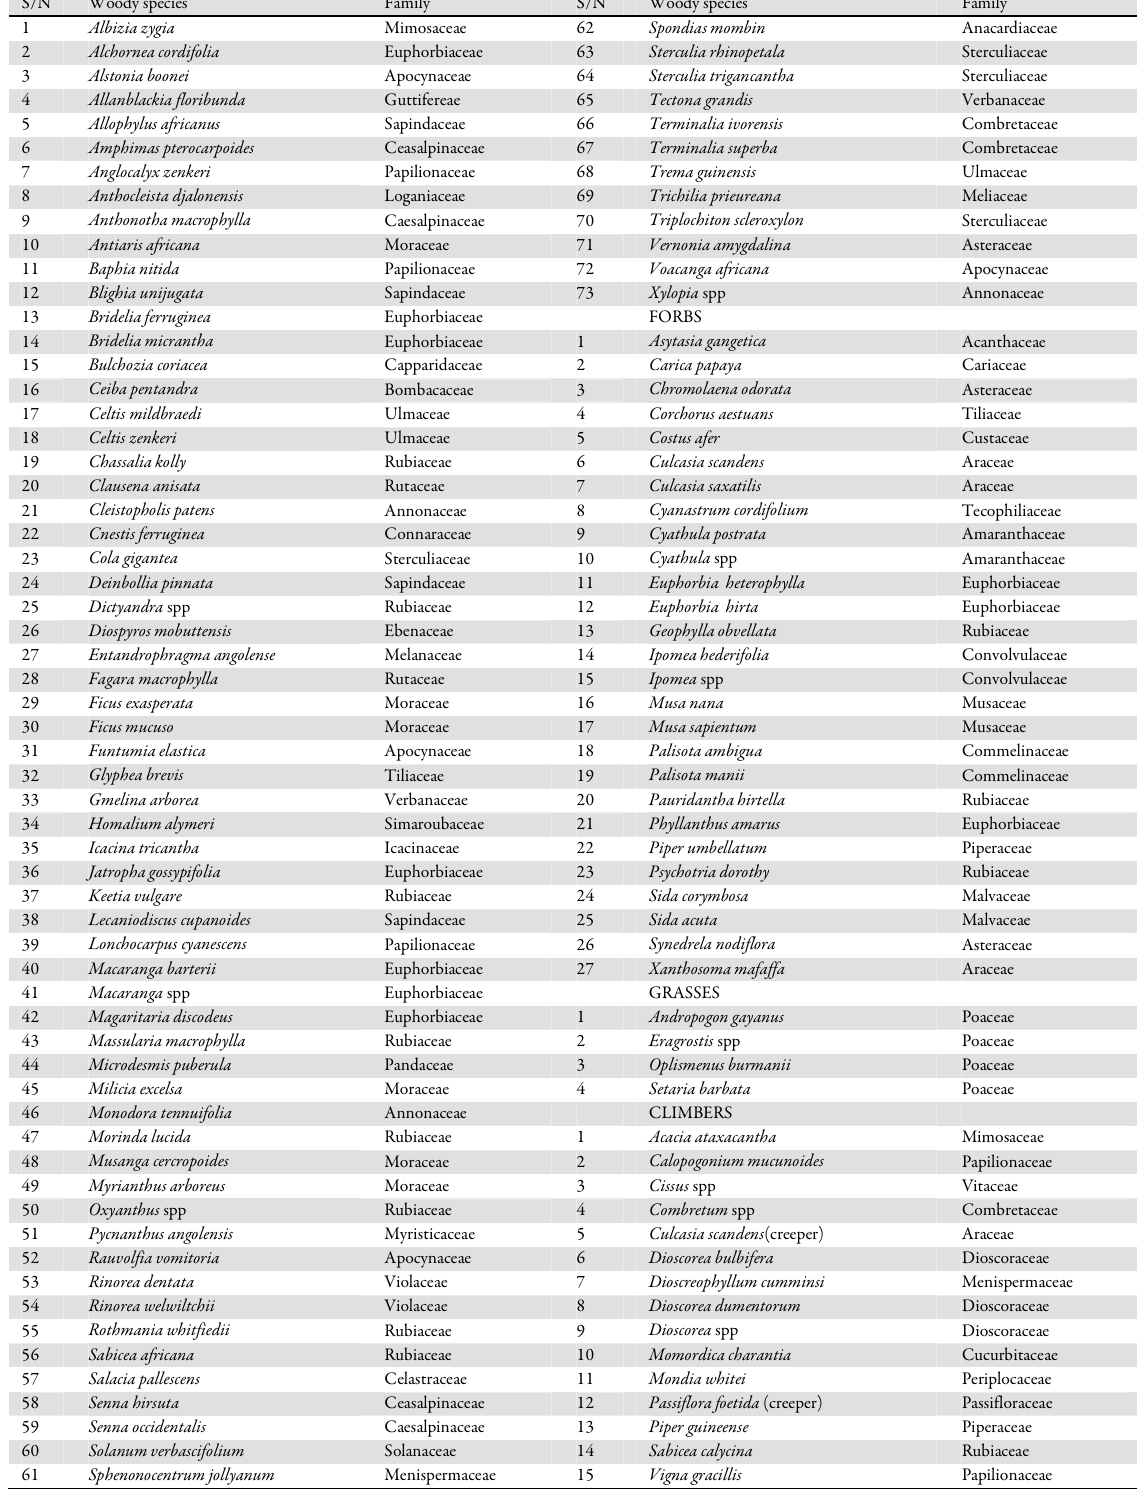
Tab. 1. List of plant species encountered in the three study sites in Shasha forest